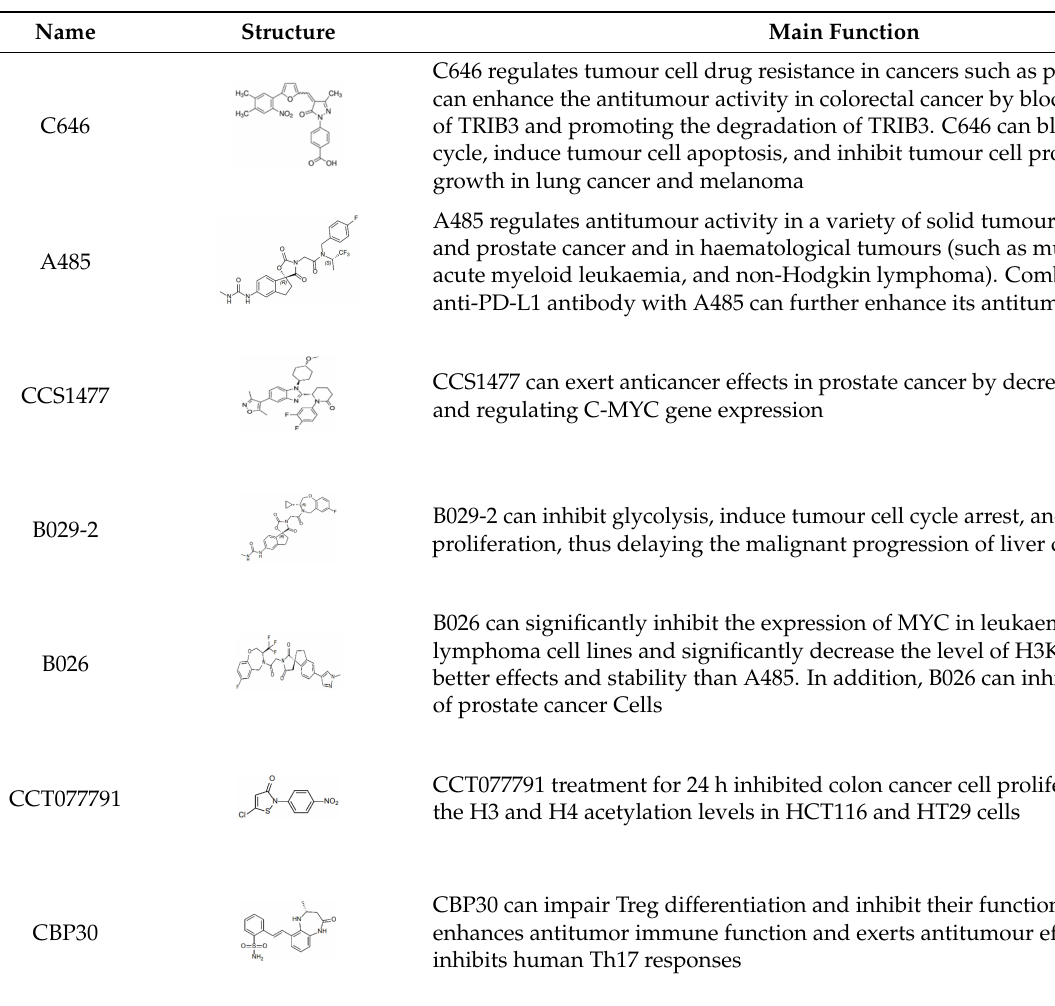
Table 3. Summary of representative p300 inhibitors and their main